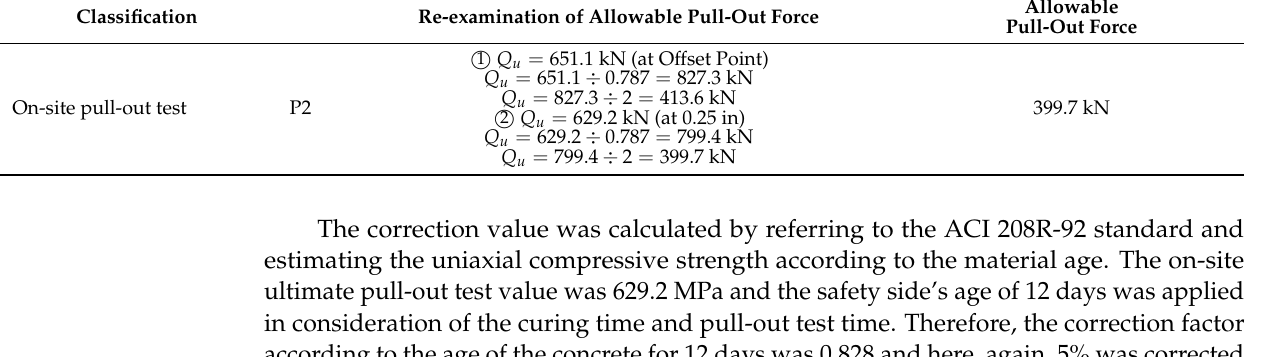
Table 7. Re-examination of allowable pull-out force according to the results of the pull-out load test.